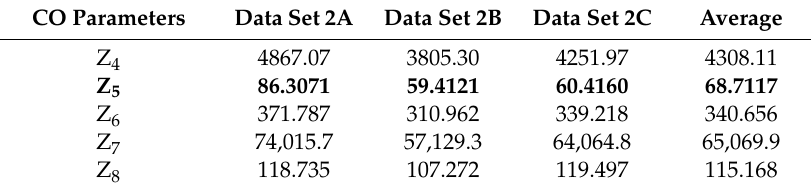
Table 7. Average across the nine SA runs for the µ * values of each data set with the 0.5 wt% Pt, 25 wt% Co / Al 2 O 3 catalyst.